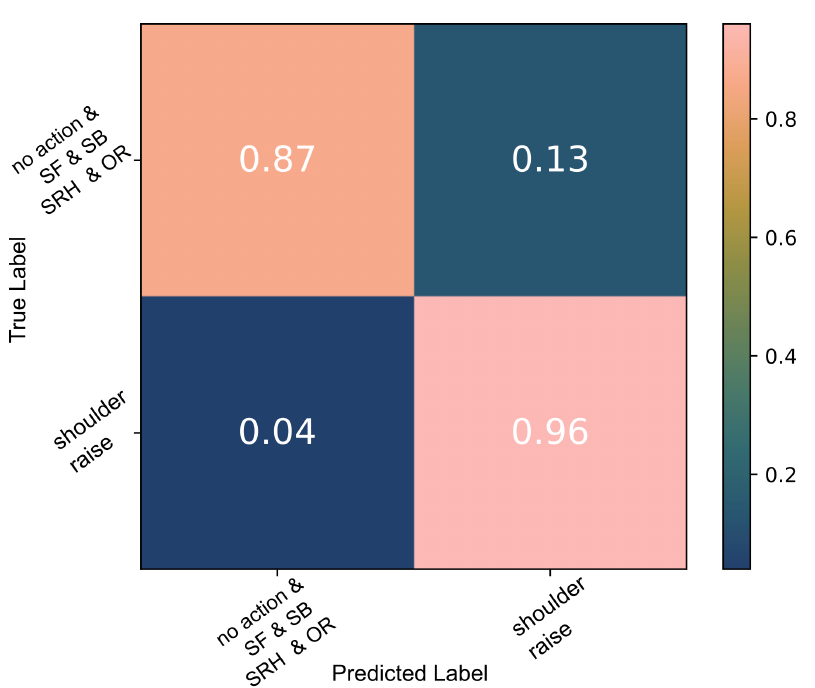
Figure 6. The thresholding algorithm SR classification results of able-bodied participant data; the model was tested against all data, including the unknown SRH and OR